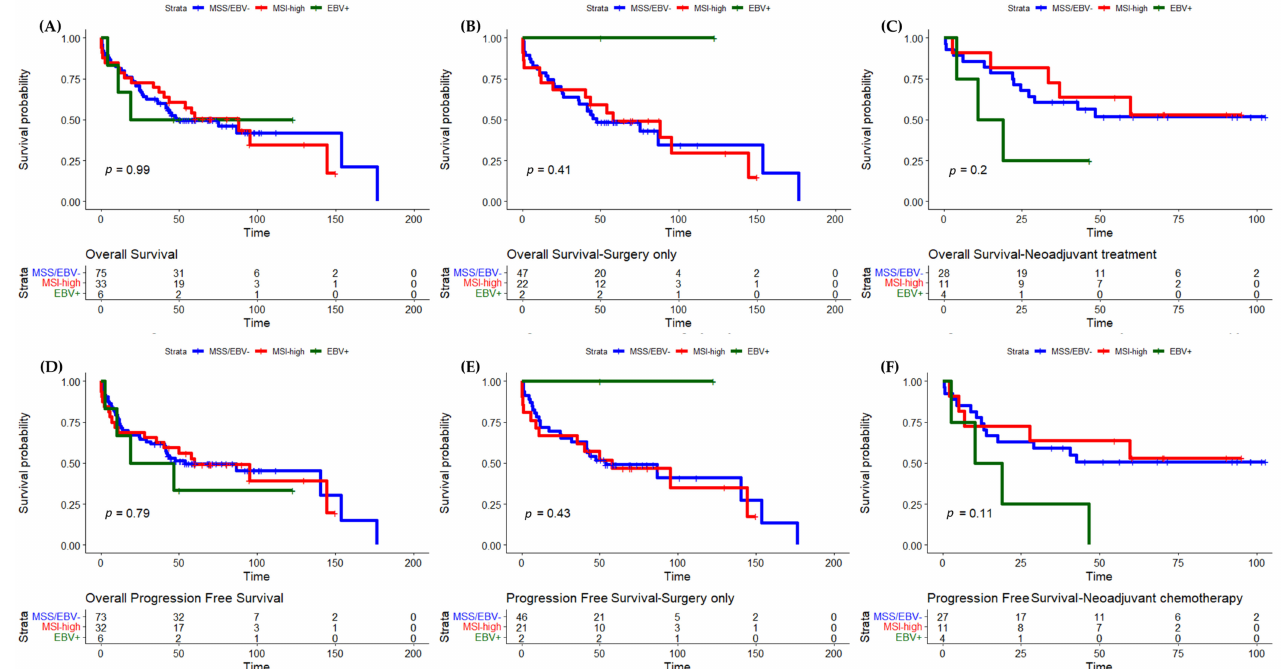
Figure 1. Differences in overall survival and progression-free survival between MSS/EBV − , MSI- high, and EBV+ were assessed using the Kaplan–Meier method and compared using the logrank test. ( A ) OS of the whole cohort. ( B ) OS of patients treated with surgery only. ( C ) OS of patients submitted to neoadjuvant ChT. ( D ) PFS of the whole cohort. ( E ) PFS of patients treated with direct surgery. ( F ) PFS of patients submitted to neoadjuvant ChT. EBV, Epstein–Barr-virus-positive; MSI-high, high microsatellite instability; MSS, microsatellite stable; ChT,